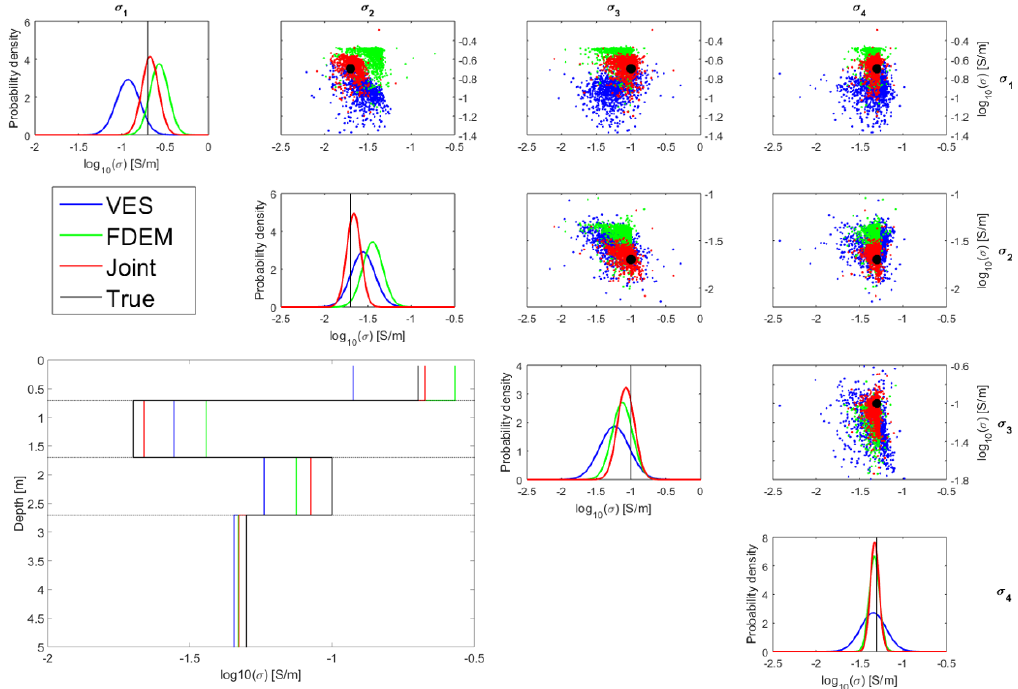
Figure 2. Covariance matrix-like arrangement of scatter plots of the 1000 KEG samples of all parameter pairs from the posterior models for separate (blue and green) and joint (red) inversion of FDEM and VES data, including a larger black dot for the synthetic true solution. The four plots on the diagonal show the respective Gaussian posterior probability functions. The true subsurface model is shown in the lower left corner (black solid line) with its layer boundaries (black dashed line) being accompanied by the best fit (posterior mean) estimates derived from the respective separate and joint